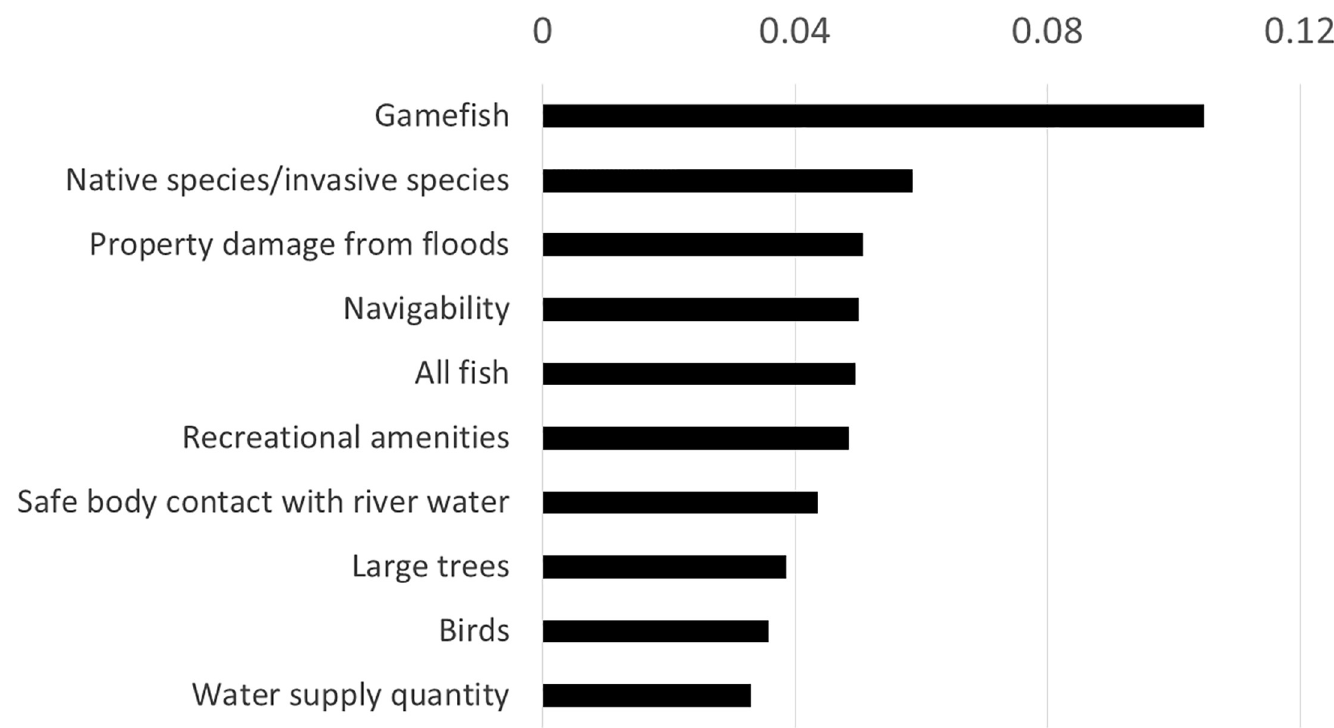
Fig 3. Top ten theme frequency percentages; all segments combined. These themes account for the majority of combined input (bars sum to 51%).